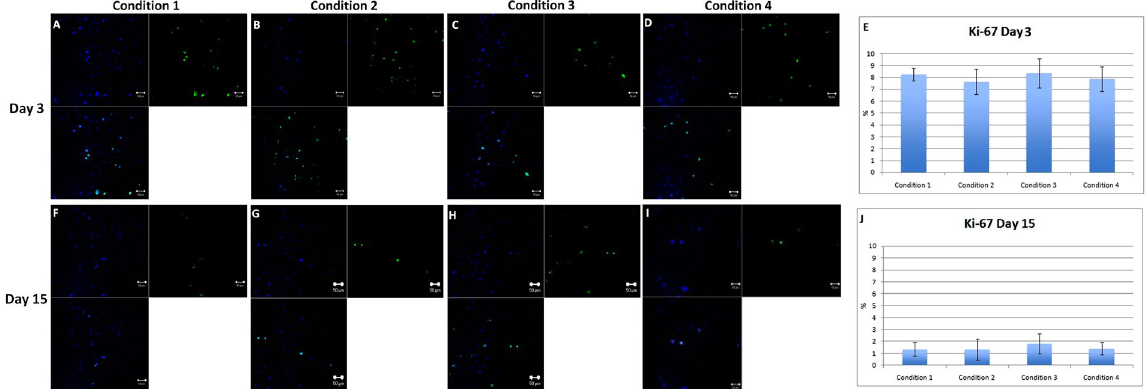
Figure 5. Expression of Ki-67, proliferative marker. ( A – D ) Ki-67 was almost equally expressed in all four conditions, which highlights that the plating density of proliferative cells was almost equal in all the conditions at day 3. ( F – I ) At day 15, number of Ki-67 cells decreased in all four conditions without any statistical significance. ( E ) Graphical representation of the number of cells that expressed Ki-67 at day 3 and ( J ) at day 15. Scale bar = 50 µ m.